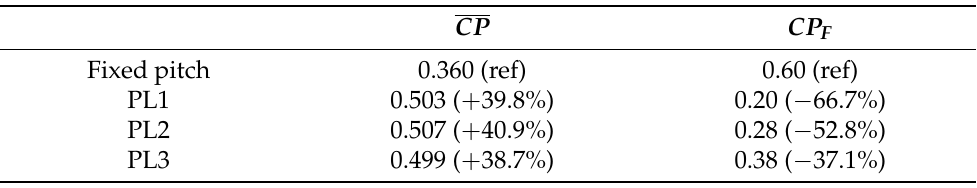
Table 2. Power coefficient: average ( CP ) and ripple factor ( CP F = CP max fixed and variable pitch cases.